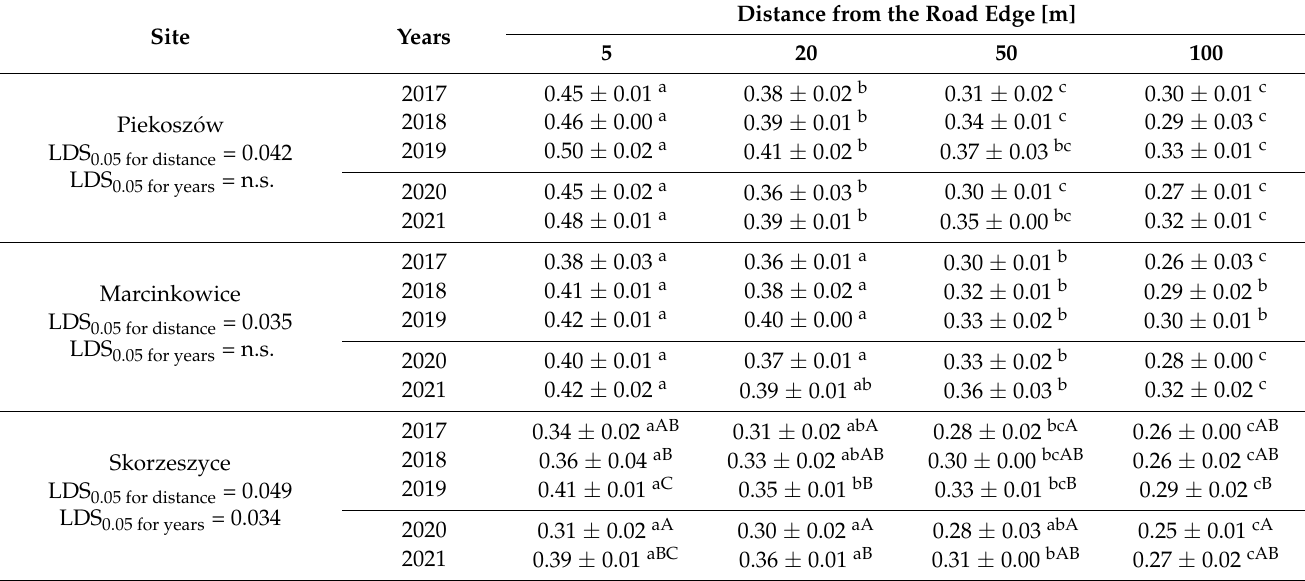
Table 6. Cadmium content (Cd in mgkg − 1 ) in soils before the COVID-19 pandemic (2017–2019) [28,29] and during the pandemic